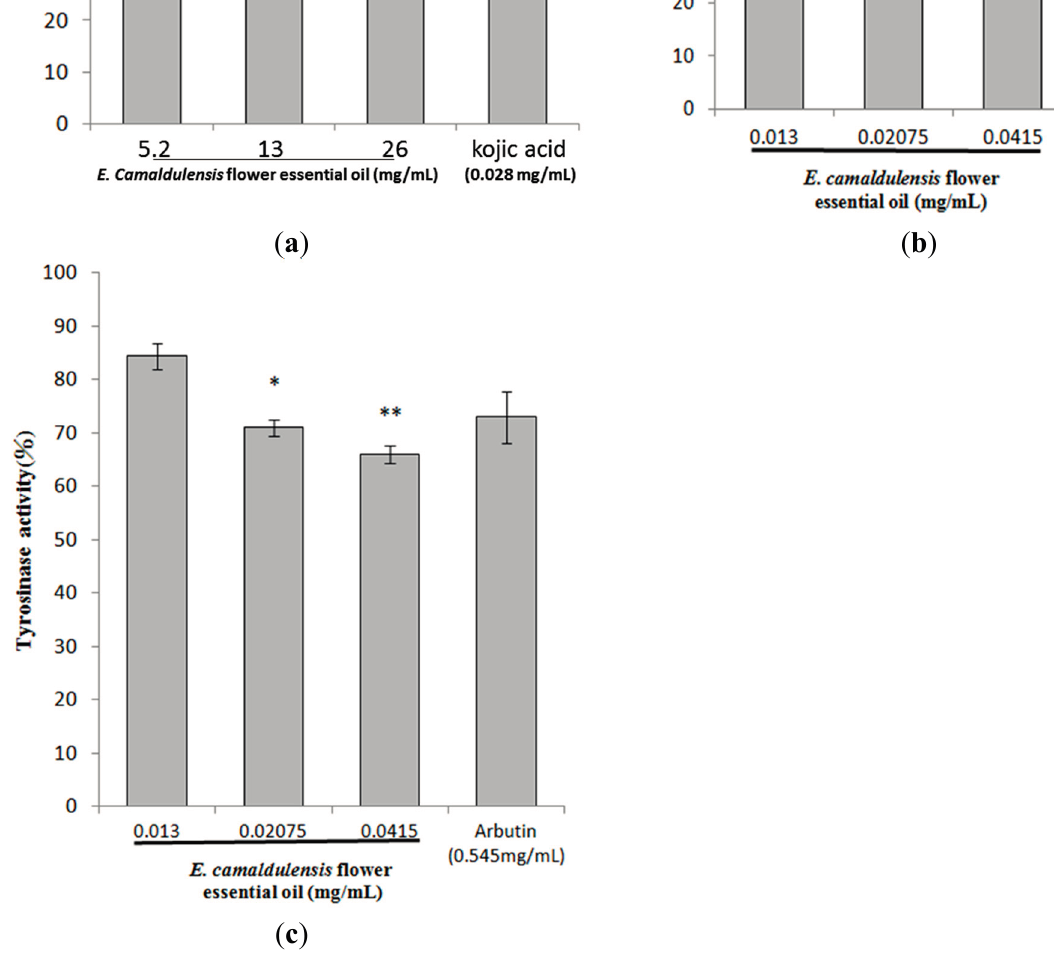
Figure 2. The inhibitory effects of E. camaldulensis flower essential oil on melanogenesis. ( a ) The effects of E. camaldulensis flower essential oil on mushroom tyrosinase activity; ( b ) The effects of E. camaldulensis flower essential oil on melanin content in B16F10 cells; ( c ) The effects of E. camaldulensis flower essential oil on tyrosinase activity in B16F10 cells. The results are presented as percentages of the control, and the data are presented as the mean ± S.D. of three separate experiments. Values significantly different from the control are indicated. * p < 0.05; ** p <